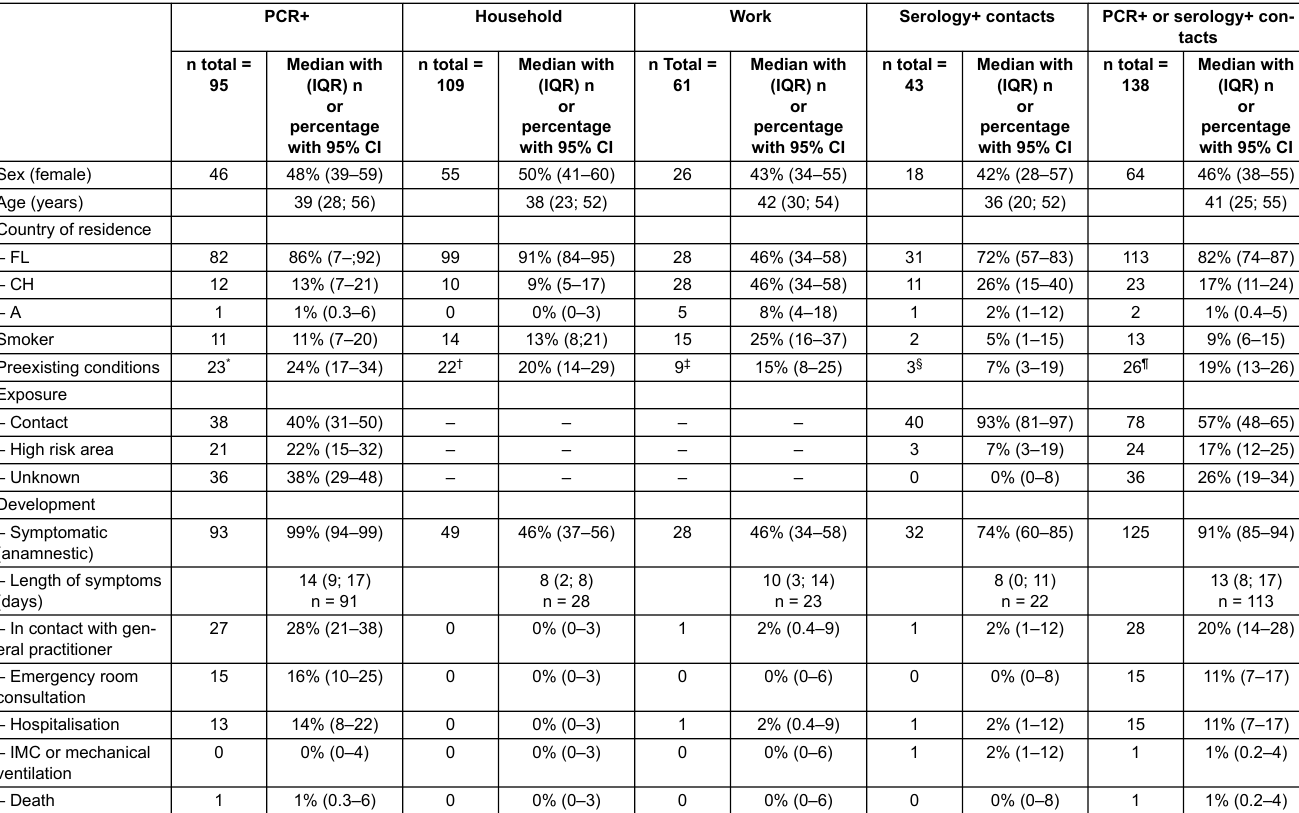
Table 1: Patient characteristics. Columns depicting the patient characteristics for all RT-PCR confirmed patients (PCR+), all household contacts (Household), all work contacts (Work), contacts with positive serology (Serology+ contacts), and all confirmed COVID-19 patients (PCR+ or serology+ contacts) PCR+ Household Work Serology+ contacts PCR+ or serology+ con-